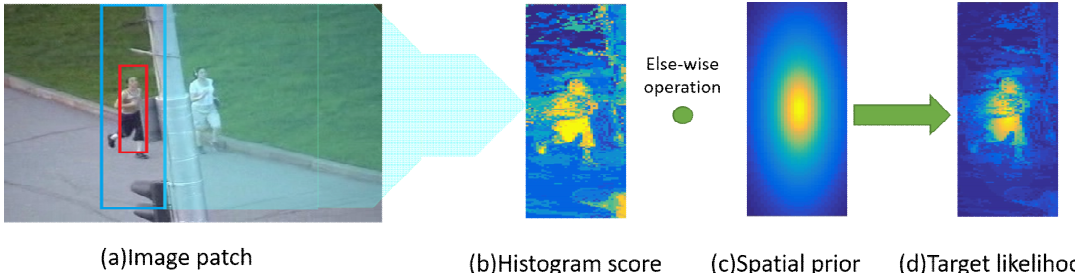
Figure 3. The input patch is shown as ( a ), where the foreground and background of the target are extracted from the red and blue bounding boxes, respectively. ( b ) shows histogram score which is obtained according to the color model in the search area and can reflect the differences between the target and background interference. Spatial prior at ( c ) indicates that the features at the center are more important than the features around. Combining the histogram score and spatial prior, the target likelihood can enhance the target features while suppressing the surrounding-distractors, which is shown as ( d ).